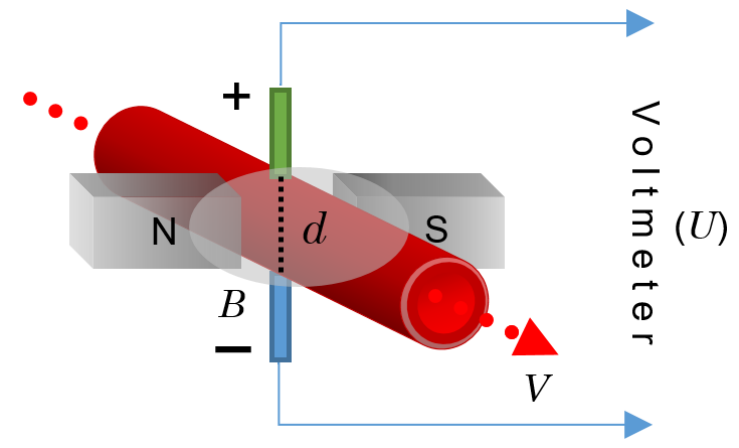
Figure 12. Diagram of an electromagnetic flowmeter: V represents the blood flow velocity, U is the electromotive force, B is the magnetic flux density, and d is the channel diameter.